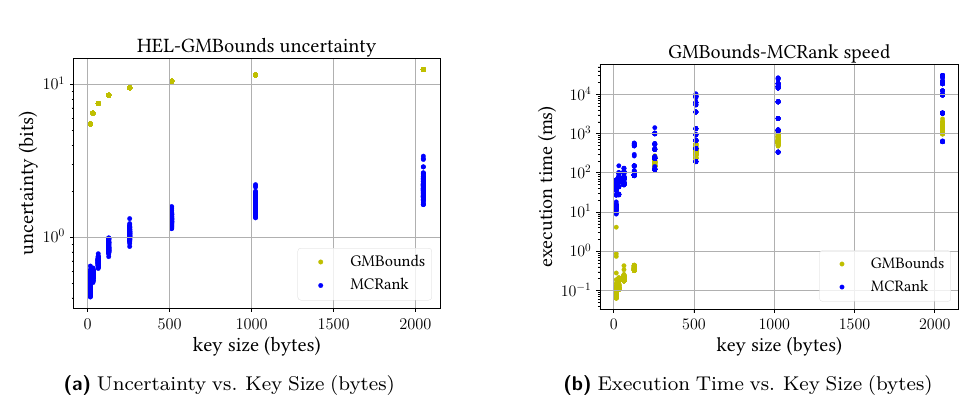
Figure 6: Qualitative comparison between GMBounds [CP17] (Massey’s guessing entropy) and MCRank (key rank) for the RSA key-load attack. MCRank has higher/similar execution time (b), but lower uncertainty (a) even with a small sample size (GMBounds’ uncertainty cannot be controlled). Experiments are run for increasing key size and fixed sample size (1000). For large keys, [CP17] uses Matlab’s symbolic values for variable precision, with a significant